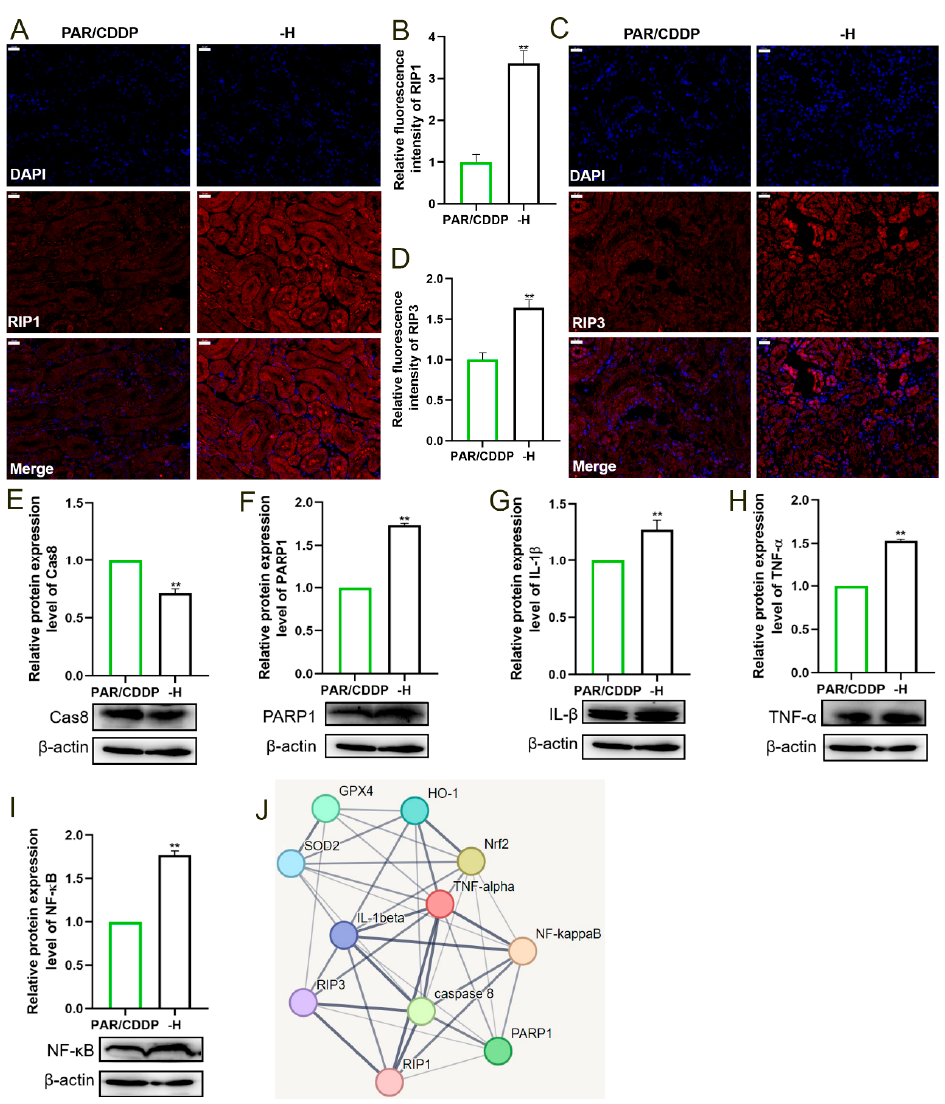
Figure 7. Inhibiting HO-1 expression reduces the anti-inflammatory levels of paricalcitol. ( A , B ) Immunofluorescence representative images and quantification of RIP1 (scale bars, 20 µ m; n = 3). ( C , D ) Immunofluorescence representative images and quantification of RIP3 (scale bars, 20 µ m; n = 3). ( E – I ) The protein expressions of Cas8, PARP1, IL-1 β , TNF- α and NF- κ B ( n = 3). ( J ) Interaction diagram of related proteins in this experiment. PAR/CDDP, paricalcitol + cisplatin group; -H, ZnPP+ paricalcitol + cisplatin group. ** p < 0.01. Dates are presented as Mean ± SD. Statistical significance was obtained by unpaired Student’s t